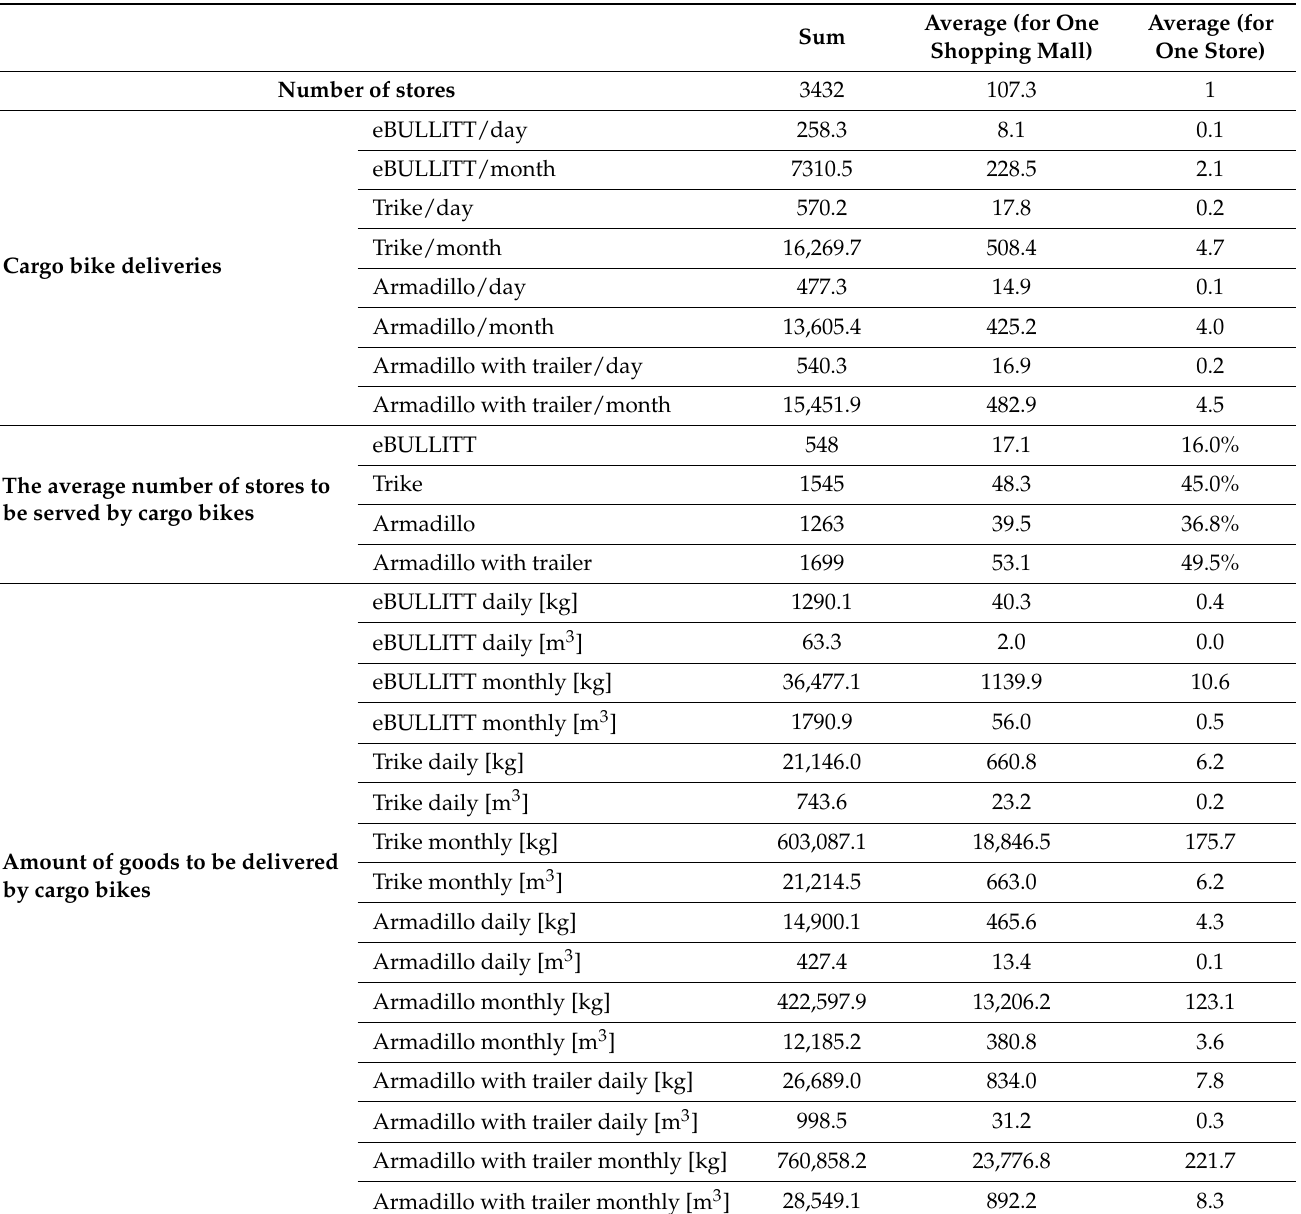
Table A4. Suitability of cargo bikes, the sum, and the average